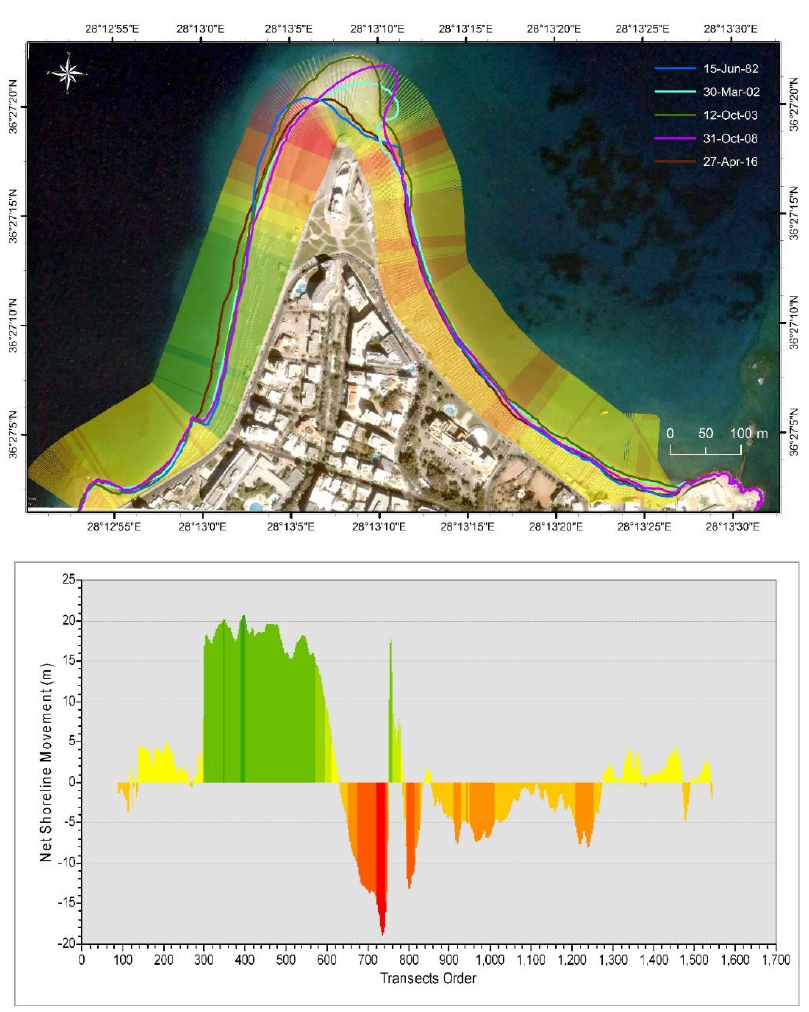
Figure 6. Long-term (1982–2016) shoreline analysis in DSAS model on both sides of the Cape Mylon.